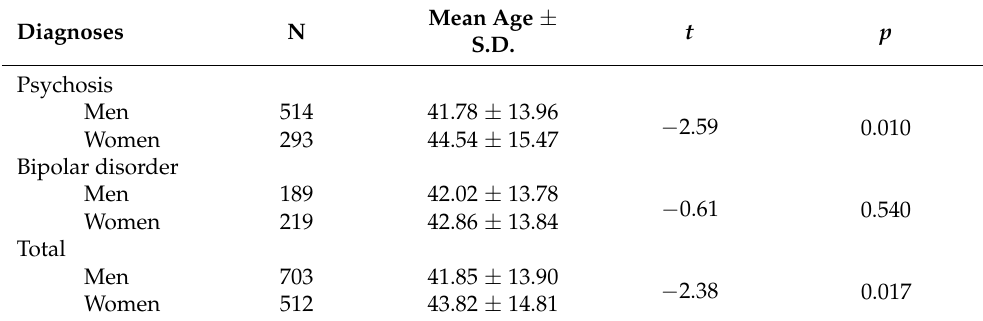
Table 6. Age of first admission of patients with severe psychiatric disorders ( n =